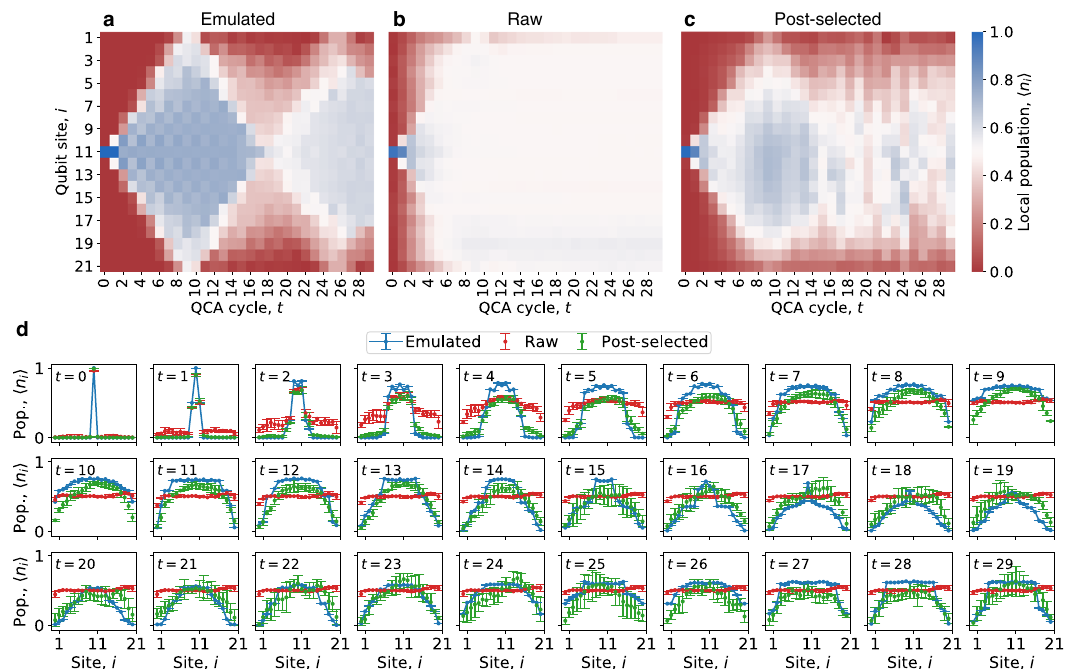
Fig. 2 | Population dynamics and post-selection. A noise-free, numerically- emulatedGoldilocksQCAoutto30cycles,initializedwithasingle ∣ 1 i inthemiddle of the 21-qubit chain. Coherent local population, 〈 n i 〉 , dynamics that resist equili- bration can be observed in the form of the two blue diamond shapes. b Raw population dynamics for the same QCA circuit averaged over four 21-qubit chains